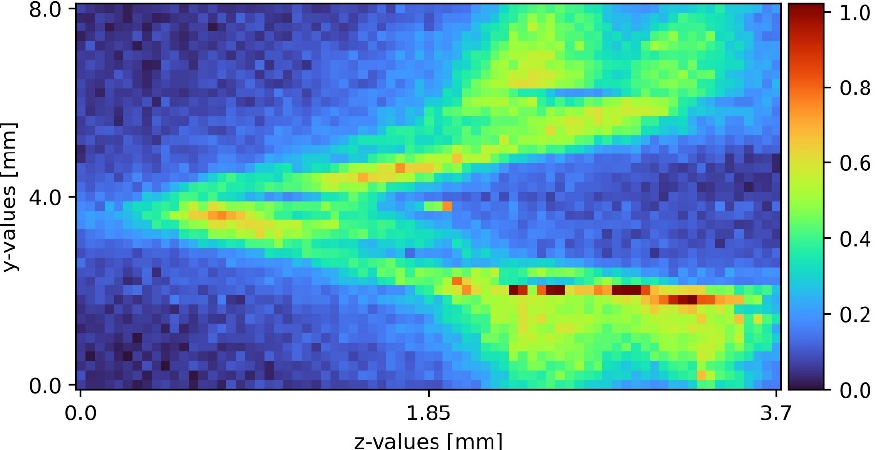
Figure 5. Sodium sulfate film on top of a pyramid-shaped disturbance.